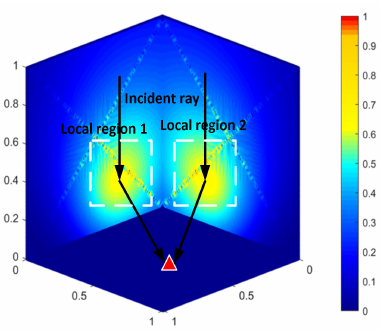
Figure 4. Normalized coupling intensity.